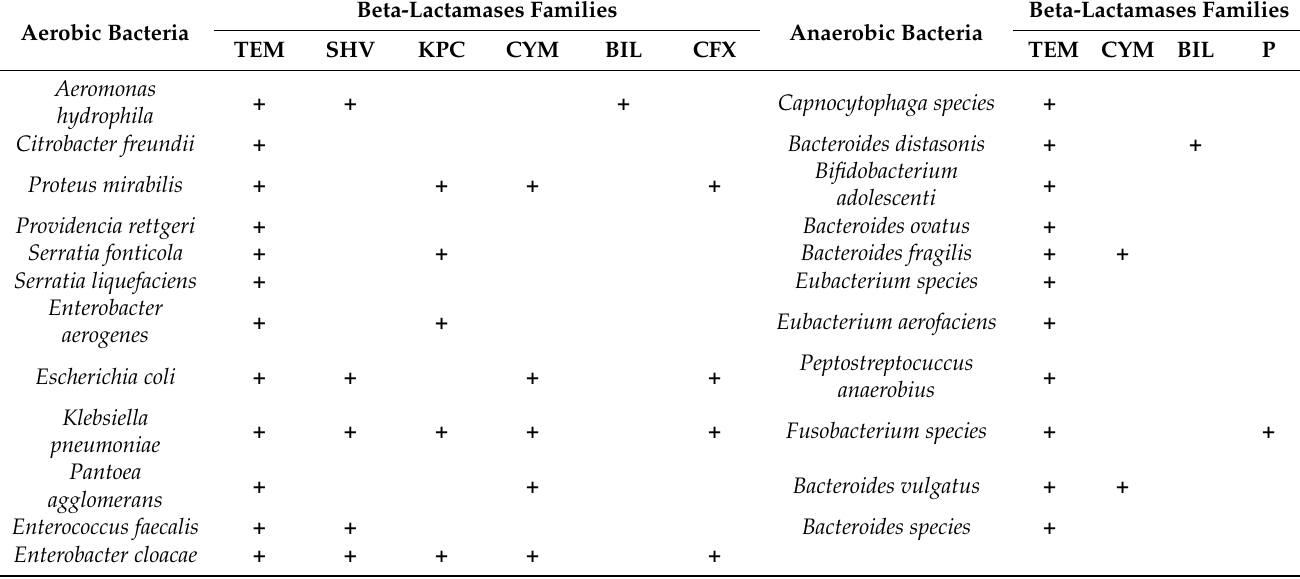
Table 5. Beta-Lactamases (bla) gene families carried by the aerobic and anaerobic Enterobacteria of humans in healthy conditions. Aerobic